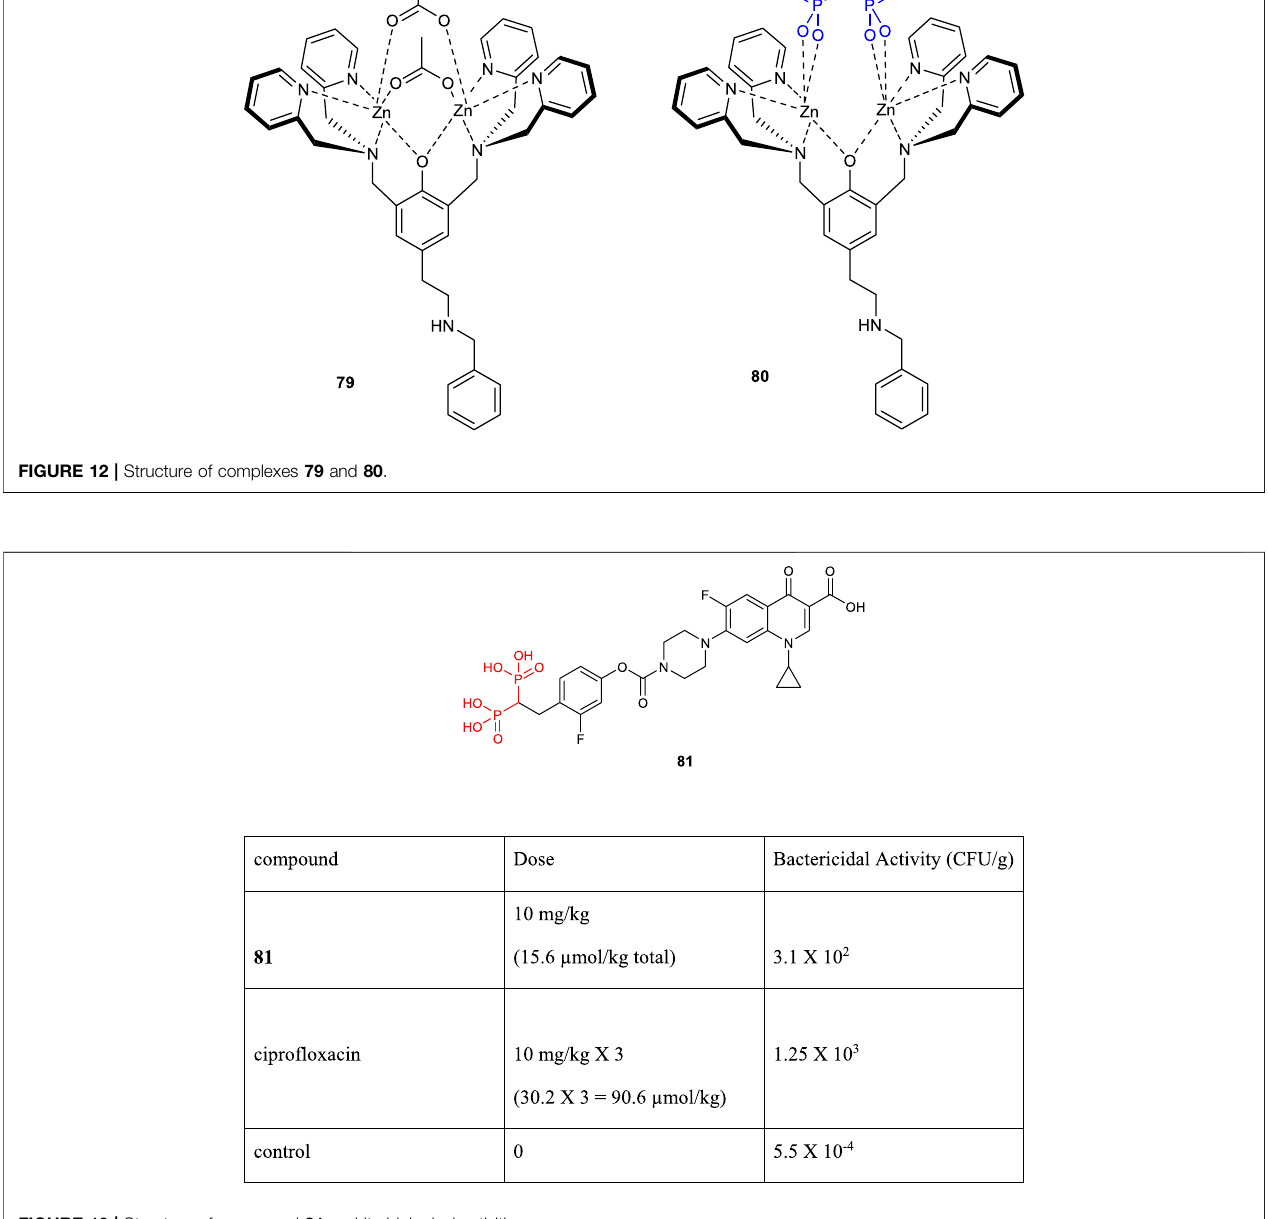
FIGURE 13 | Structure of compound 81 and its biological